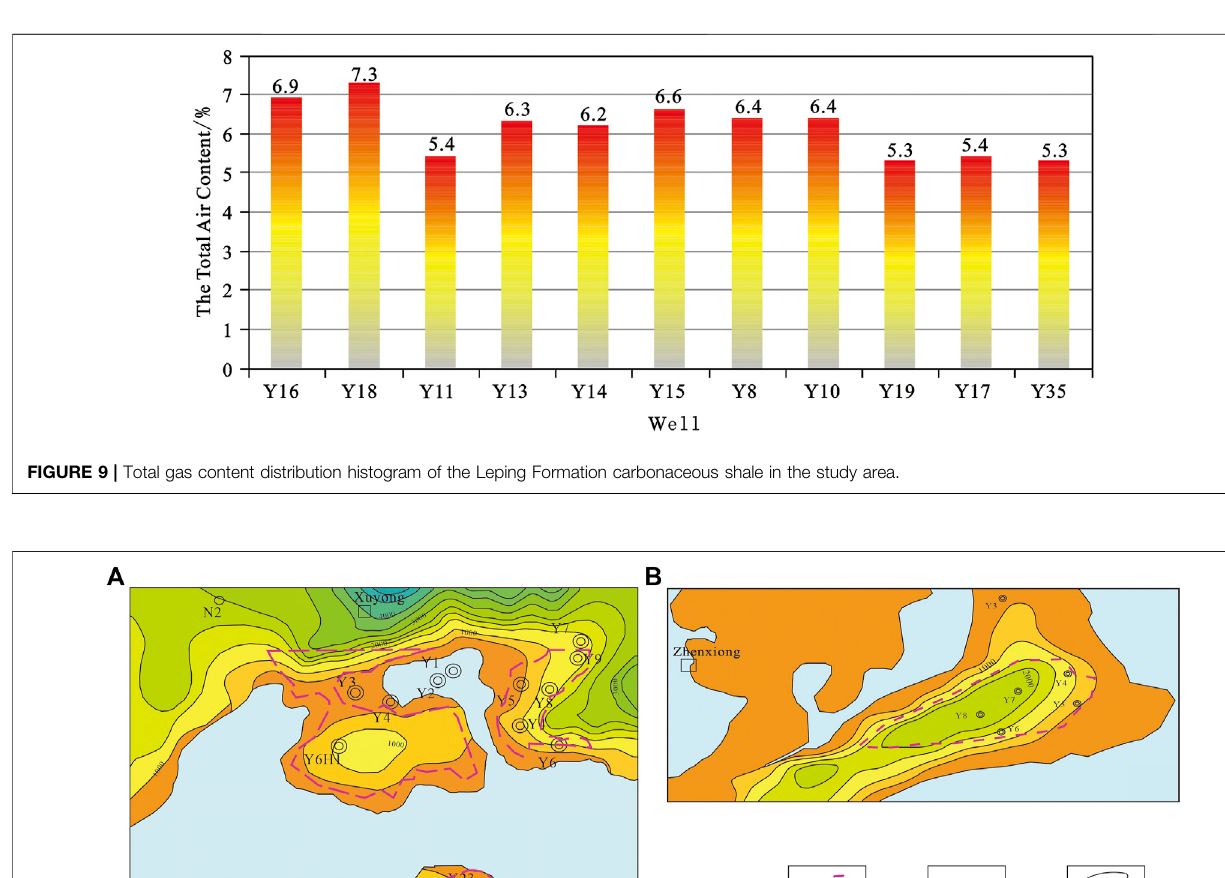
Frontiers in Earth Science |